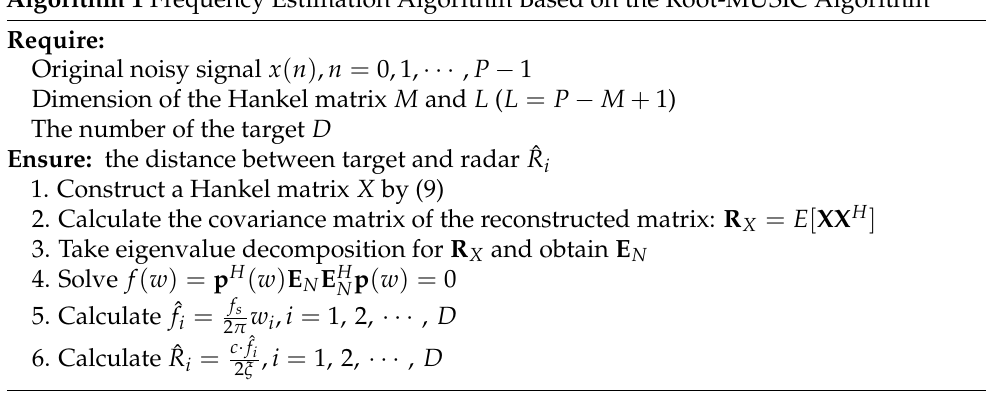
Algorithm 1 Frequency Estimation Algorithm Based on the Root-MUSIC